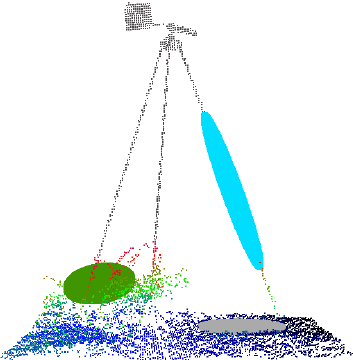
Figure 1: Three examples of ellipsoids computed over three ar- eas of interest of distinct dimensionalities for the TLS dataset (a tripod over a low and sparse vegetation – height colored).